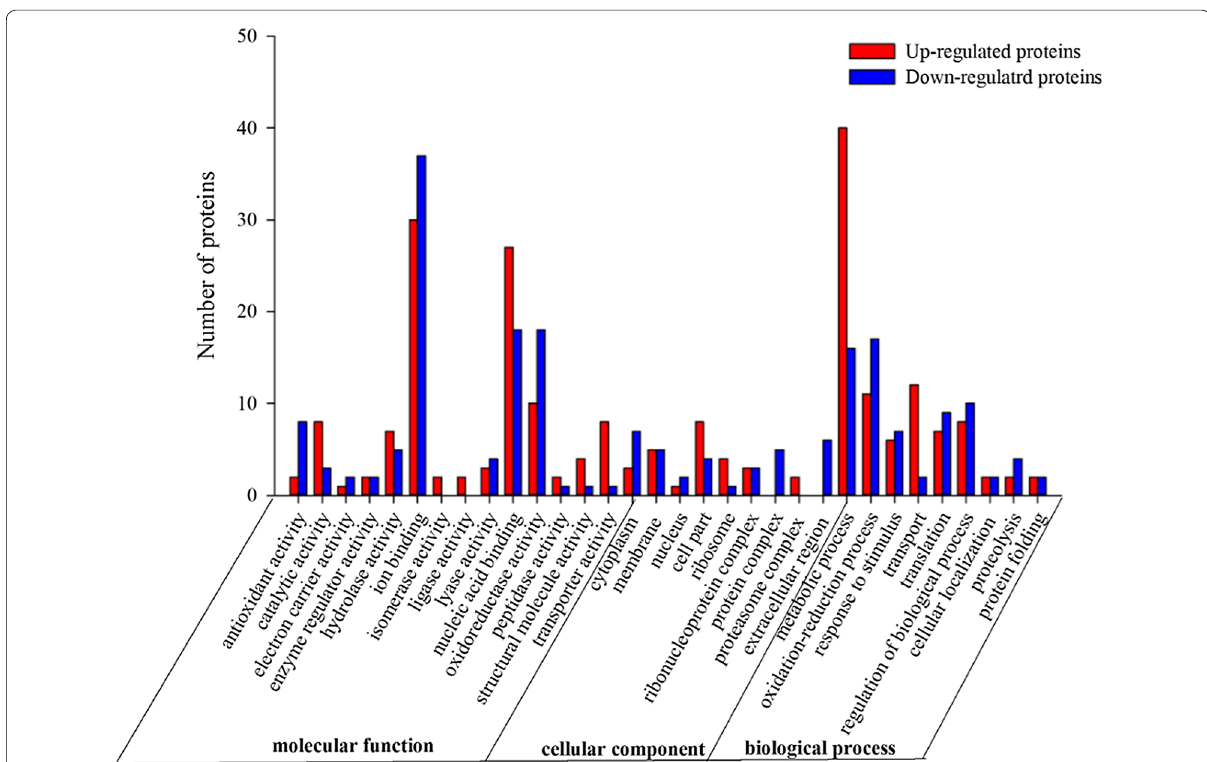
Fig. 4 GO Ontology analysis of differentially expressed proteins of compared treatment (B-CK) with the control (A-CK). The proteins were catego- rized according to the annotation of GO, and the number of each category is displayed based on biological process, cellular components, and molecular functions. Red color bars indicate up-regulated and blue color bars indicate down-regulated